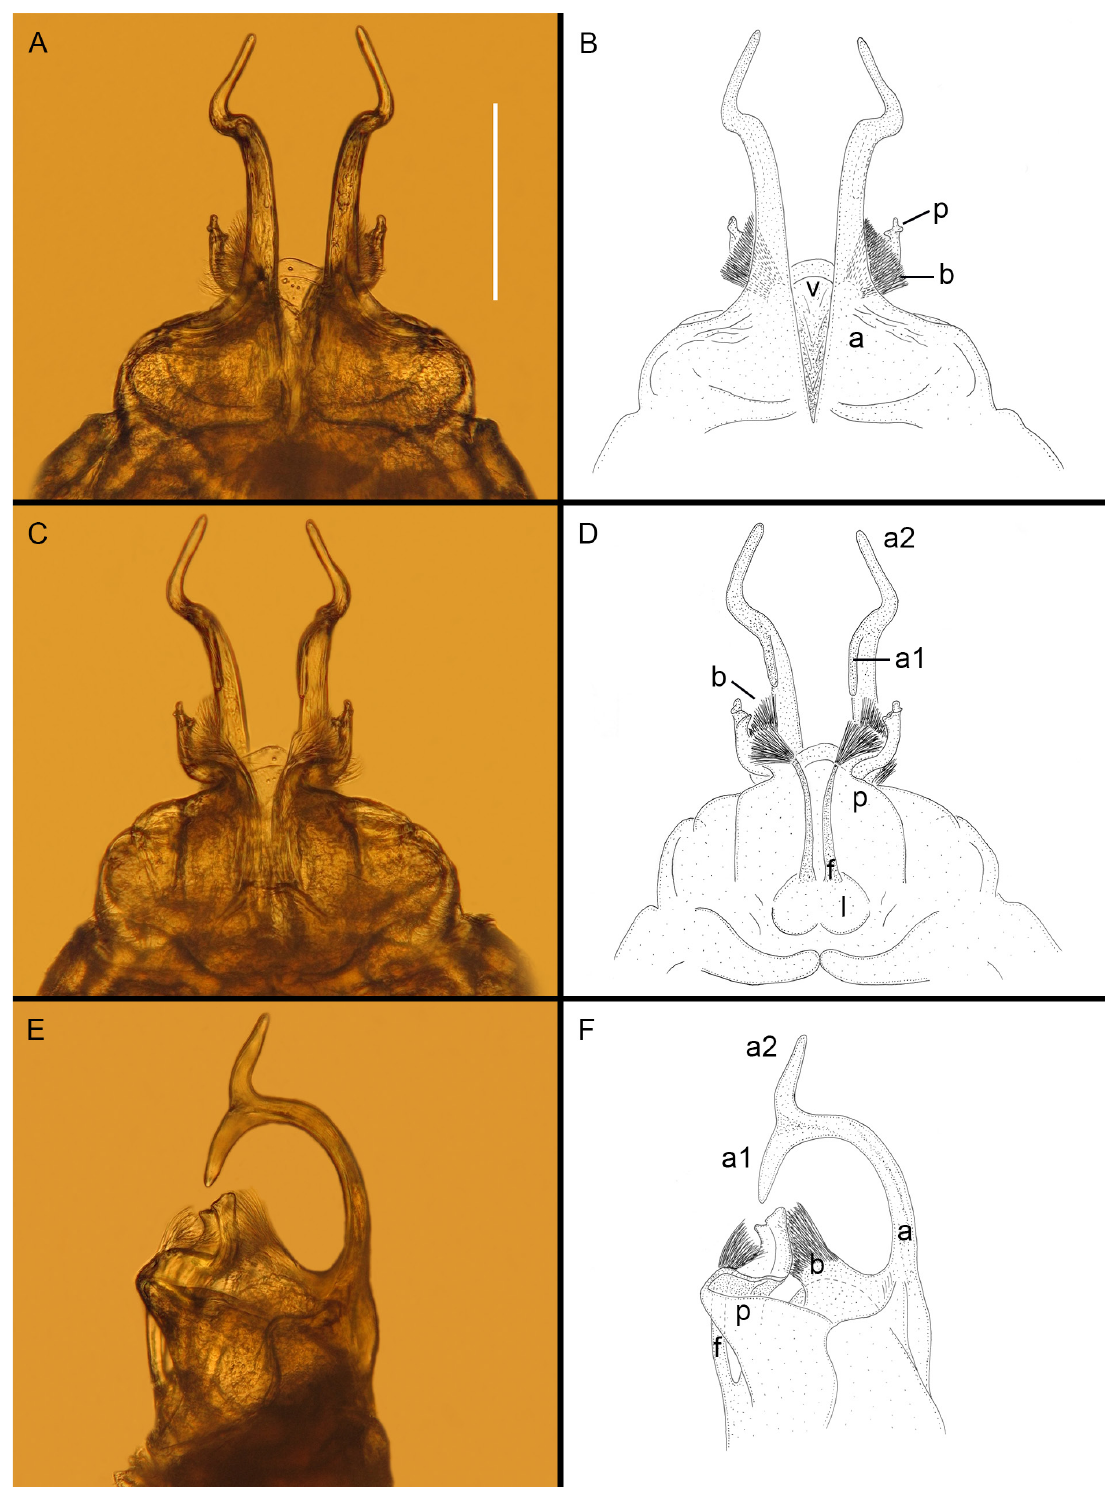
Fig. 7. Biokoviella mosorensis Antić & Dražina sp. nov., ♂, holotype, anterior gonopods. A–B . Anterior view. C–D . Posterior view. E – F . Lateral view. Abbreviations: see Material and methods. Scale line = 0.2